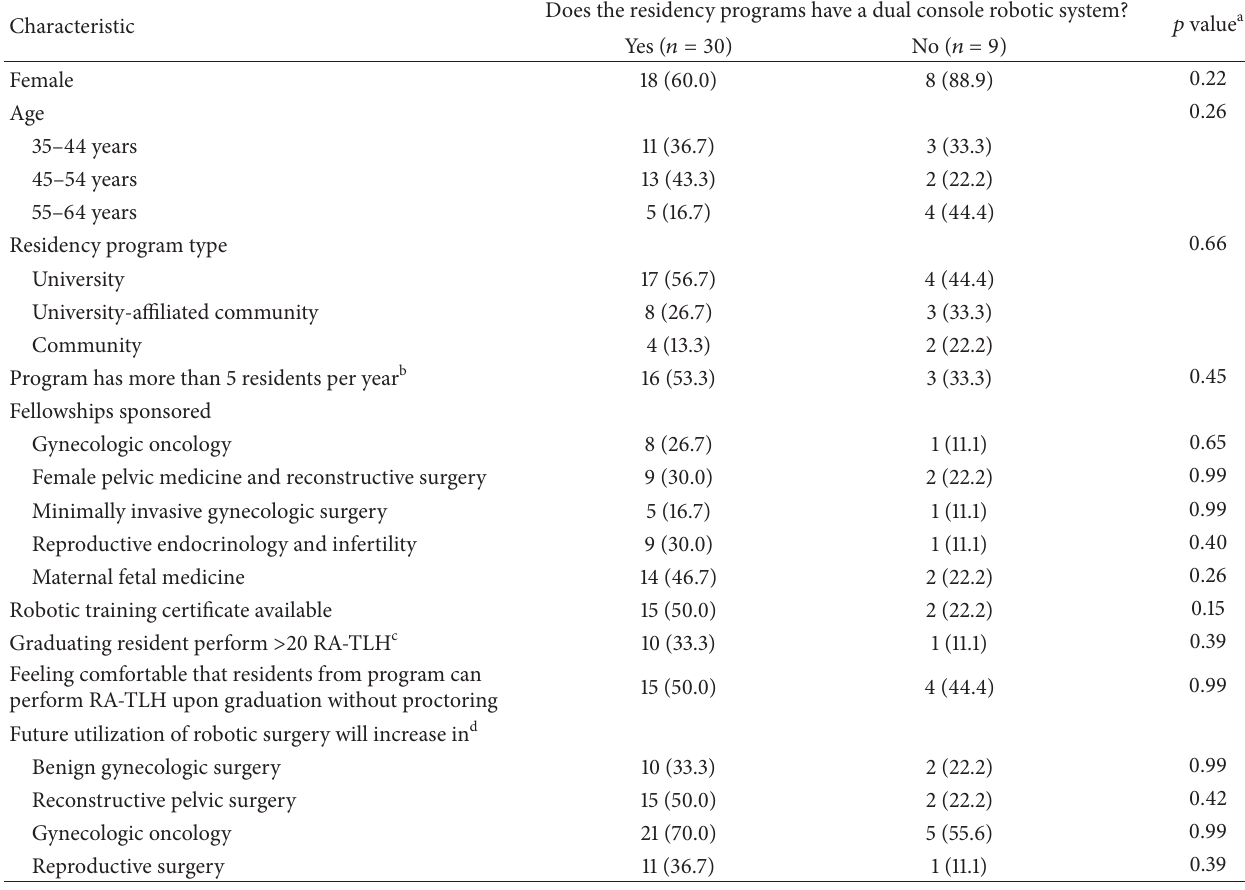
Table 2: Characteristics of residency programs with single versus dual console robotic systems, based on perceptions of residency program